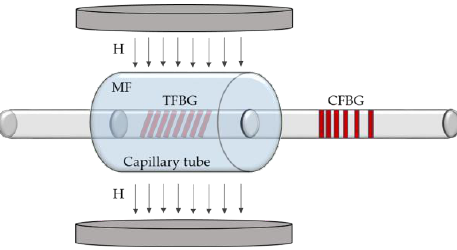
Figure 6. Experimental setup for the magnetic field measurement based on a CFBG-cascaded TFBG (adapted from [39]).